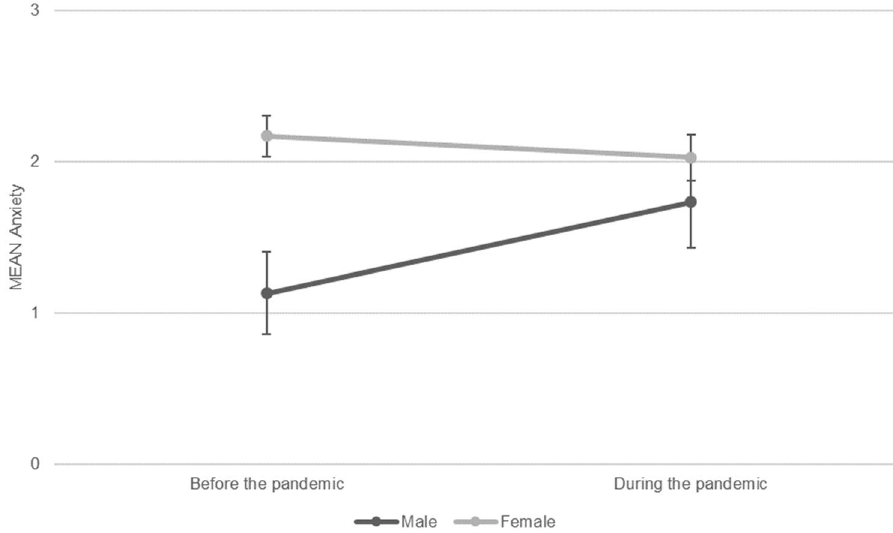
Figure 1. Anxiety predicted by time (before vs. during pandemic) and gender (male vs. female). Note F (1,421) = 5.03, p = .025, small effect size.